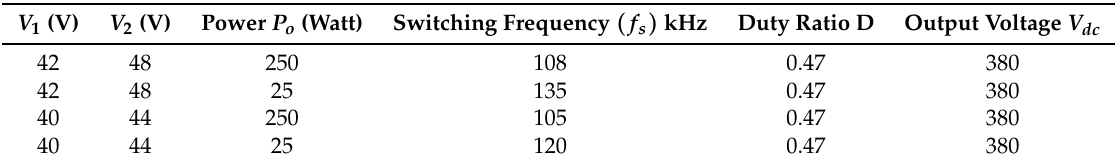
Table 2. Case study results.